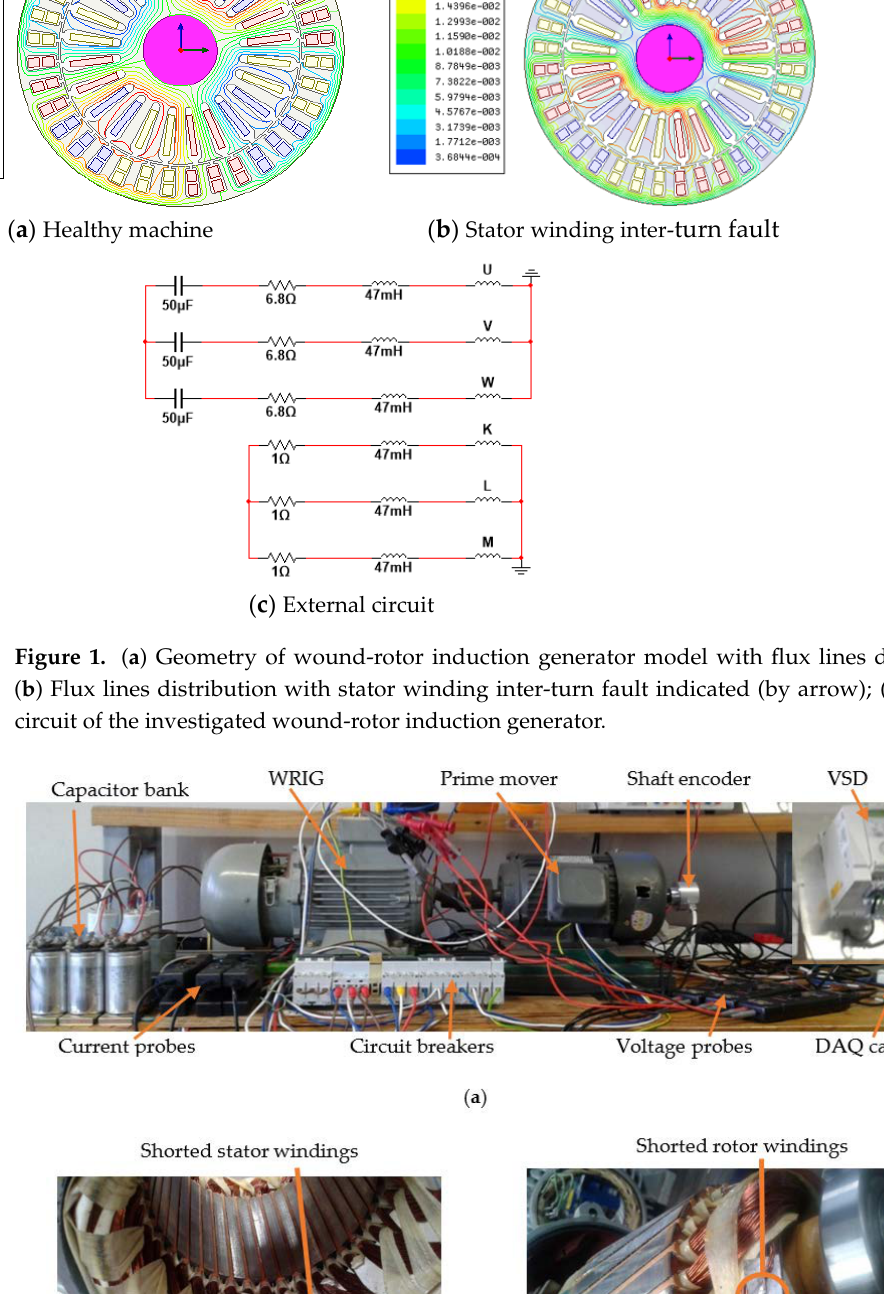
Figure 1. ( a ) Geometry of wound-rotor induction generator model with flux lines distribution; ( b ) Flux lines distribution with stator winding inter-turn fault indicated (by arrow); ( c ) External circuit of the investigated wound-rotor induction generator.